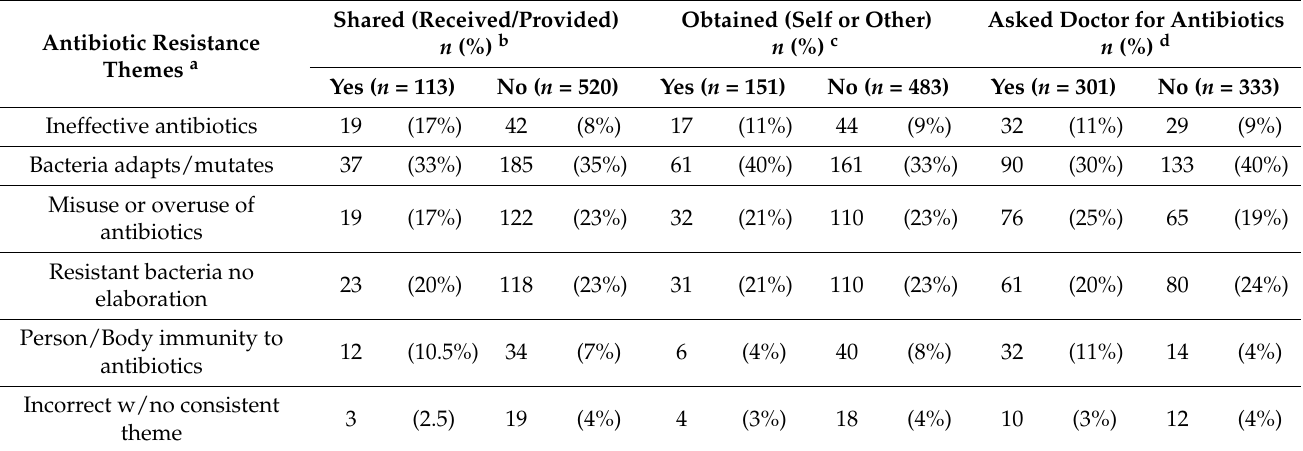
Table 3. Association between antibiotic resistance themes and antibiotic use behaviors.